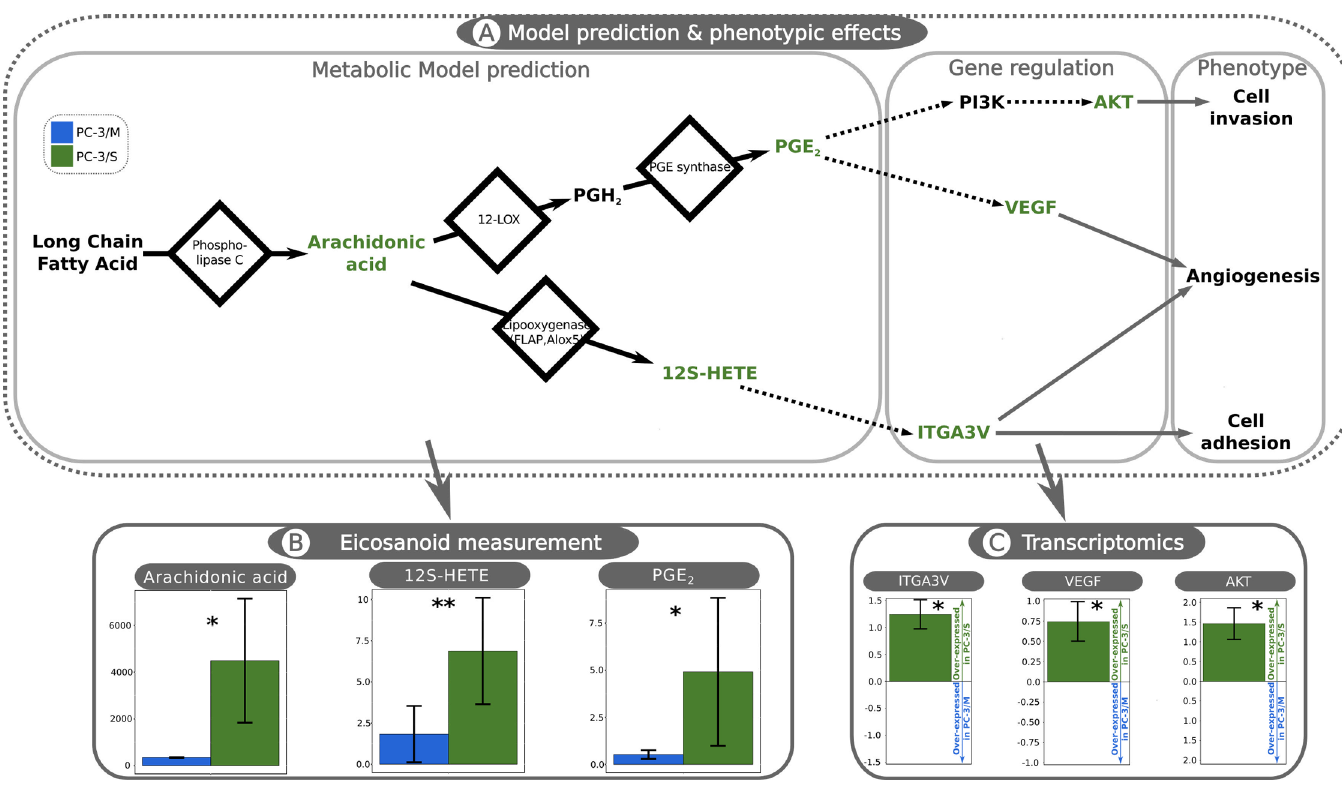
Fig 3. Metabolomic measurements reveal major differences in eicosanoid metabolism between PC-3/M and PC-3/S cells. A: Computational predictionsof Eicosanoid metabolismand reportedeffects on tumor progressioninvolvingseveralgene regulatorymechanisms. The computational analysis predicts a more active eicosanoid metabolismin PC-3/S cells. The left-most box (Metabolic Model prediction)represents a set of eicosanoid metabolism intermediates with significantdifferencesbetweensubpopulationsand their associatedreactions. Black solid arrows, metabolicreactions; nodes, metabolites; green highlight,measuredmetabolites. Long-chain fatty acids, Arachidonicacid, 12S-HETE: 12(S)-hydroxy-5Z,8Z,10E,14Z-eicosatetraenoic acid, PGH2: Prostaglandin H2, PGE2: Prostaglandin E2. The central box (Gene regulation)illustrates the gene regulatoryinteractions associated with eicosanoid metabolism. Green highlight, measured genes; black non-continuous arrows, gene regulatorypathways. ITGA3V : Integrin alpha v3; VEGF : Vascular EndothelialGrowth Factor; PI3K : Phosphoinositide3-kinase; AKT . Right panel (phenotype): reportedeffects on tumor progression,connectedto the associatedmetaboliteor gene through gray solid arrows. B: Metabolicmeasurements of detected species in both PC-3/M (blue bars) and PC-3/S cells (green bars). Shownare mean values ± sd. The units are in fmol/106cells. C: Transcript levels of genes associatedwith eicosanoid metabolismand tumor progression. The figure representsthe mean value of log2 FC betweenPC-3/S (green bars) and PC-3/M (blue bars) ± sd. Both, metabolitelevel and gene expressionwere determinedby measuring three independent samples. The level of significancewas calculatedusing the Wilcoxon-Mann-Whitney U test, where p-values < 0.05 are indicatedas “ * ” and < 0.1 as “ **